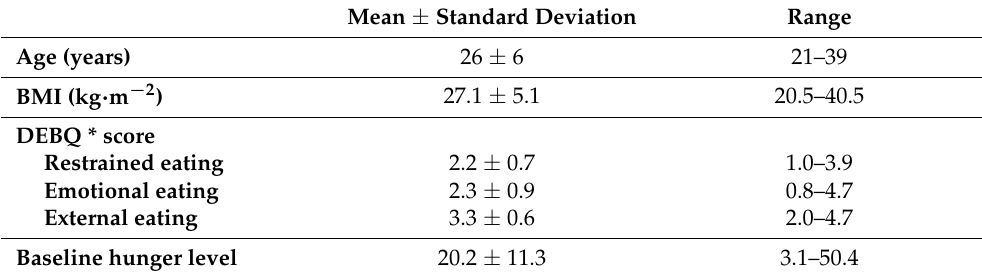
Table 3. Summary of participants’ characteristics and baseline hunger level prior to the food choice